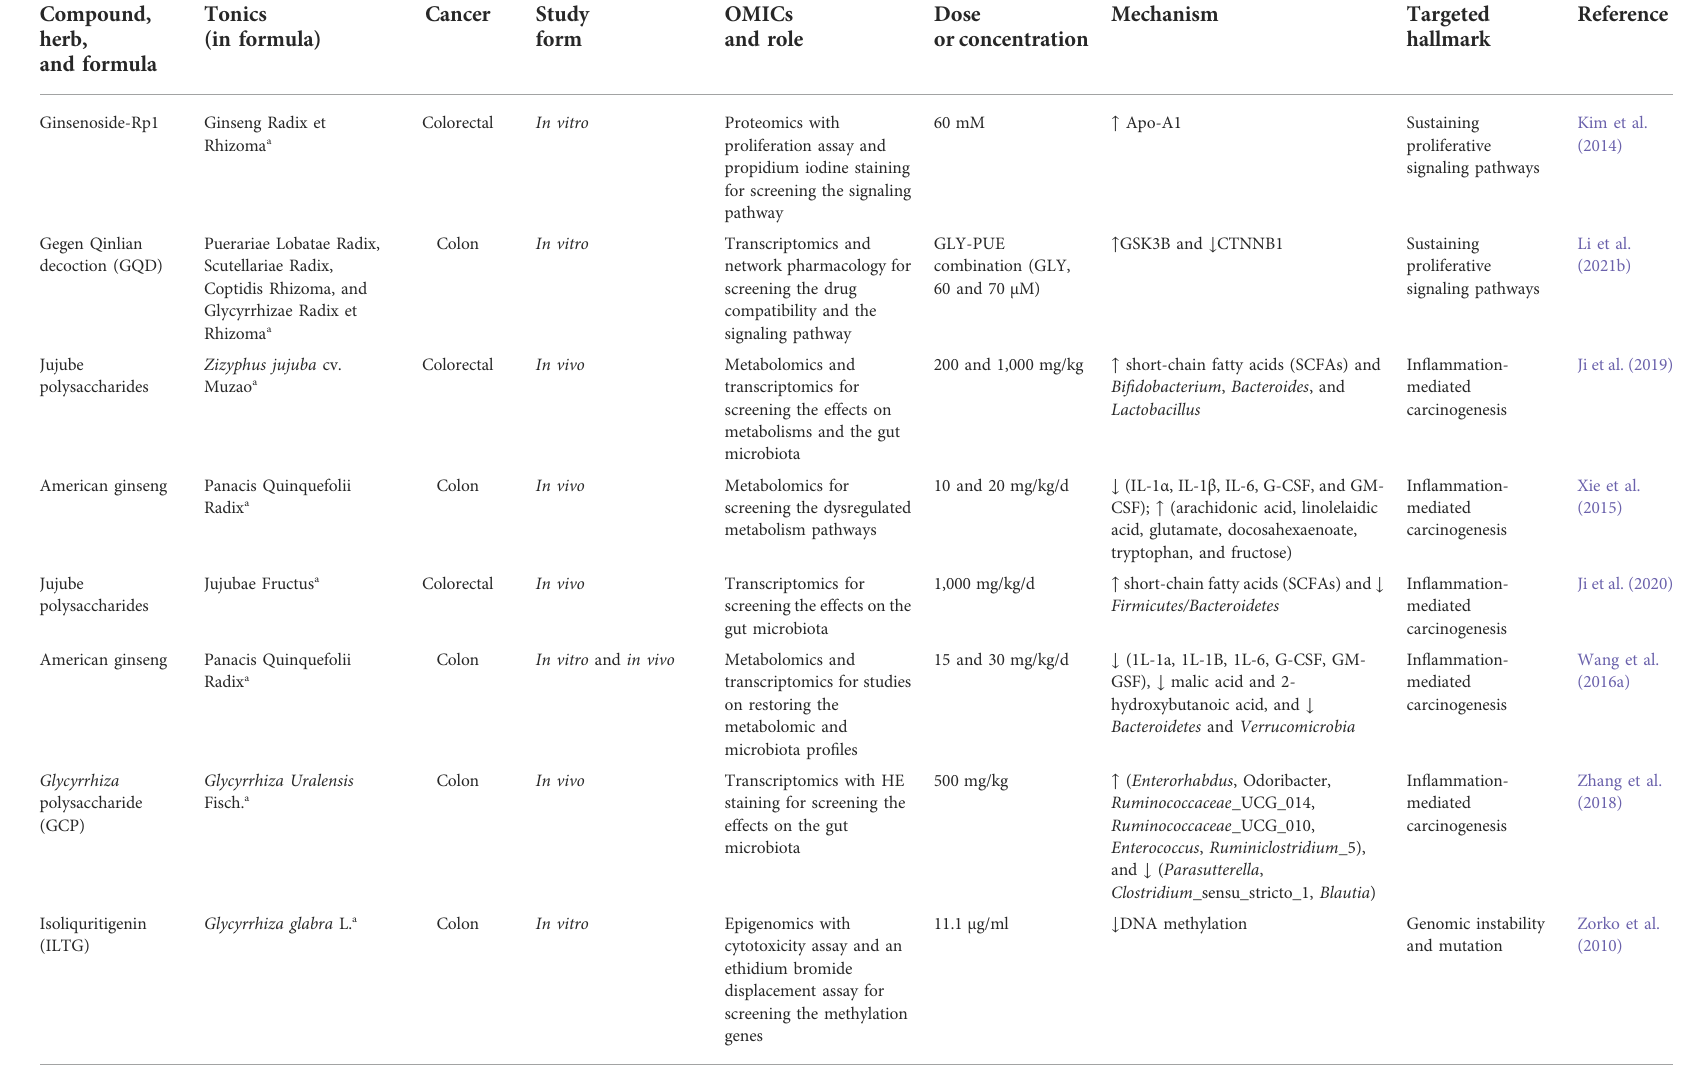
TABLE 2 Tonics targeting hallmarks as adjuvants in gastric, liver, and colorectal cancers via OMICs. Compound,